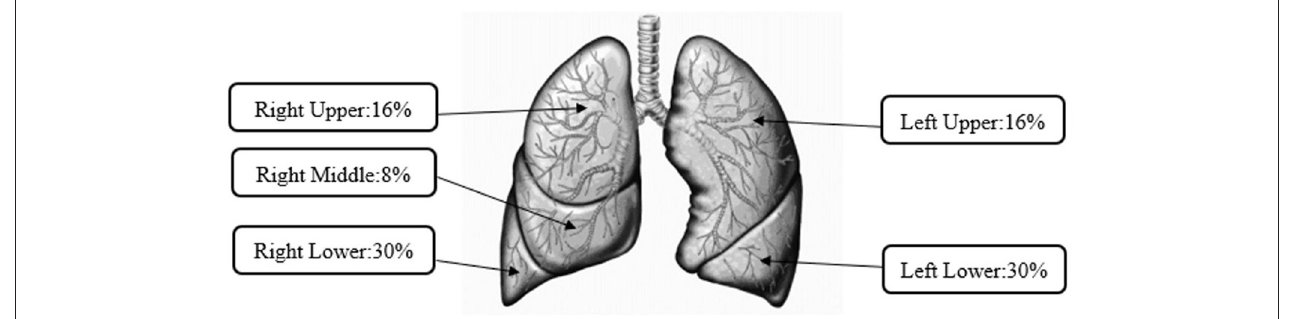
FIGURE 2 | Average lobular deposition of aerosols from pod-style electronic cigarette, or vaping, products